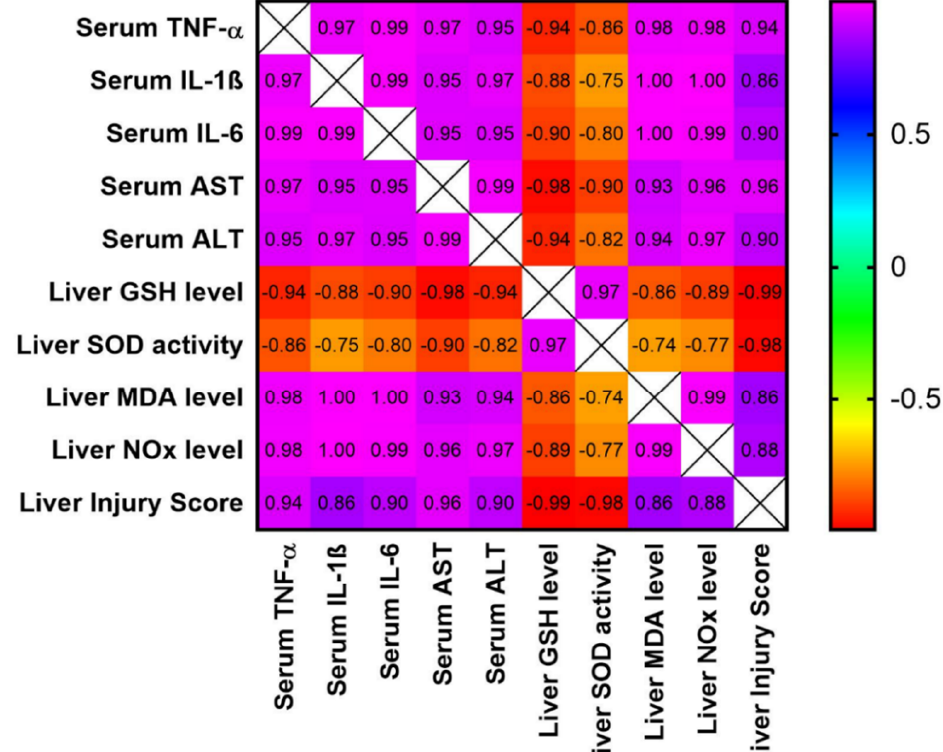
Figure 7. Correlation matrix for different parameters included in the study and the liver injury scores. The correlation coefficient used for analysis is the Pearson correlation coefficient (r). Positive values of r indicate positive correlation, while negative values indicate negative correlation. The correlation was considered strong if the value of r was between |0.6| to |0.79|, while the correlation was considered very strong if r > |0.79|. The range of the colors of the scale on the right, from violet to red, refers to r values from +1 to − 1. IL-1 β : interleukin-1b; IL-6: interleukin-6; TNF- α : tumor necrosis factor- α ; ALT: alanine aminotransferase; AST: aspartate aminotransferase.